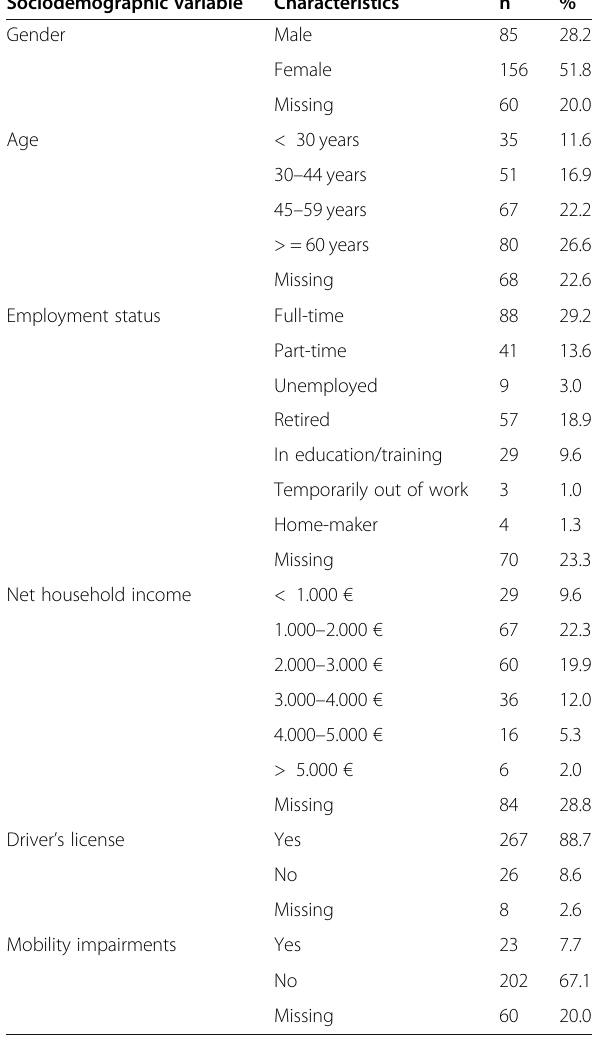
Table 1 Sociodemographic characteristics of the study sample ( N = 301) Sociodemographic variable